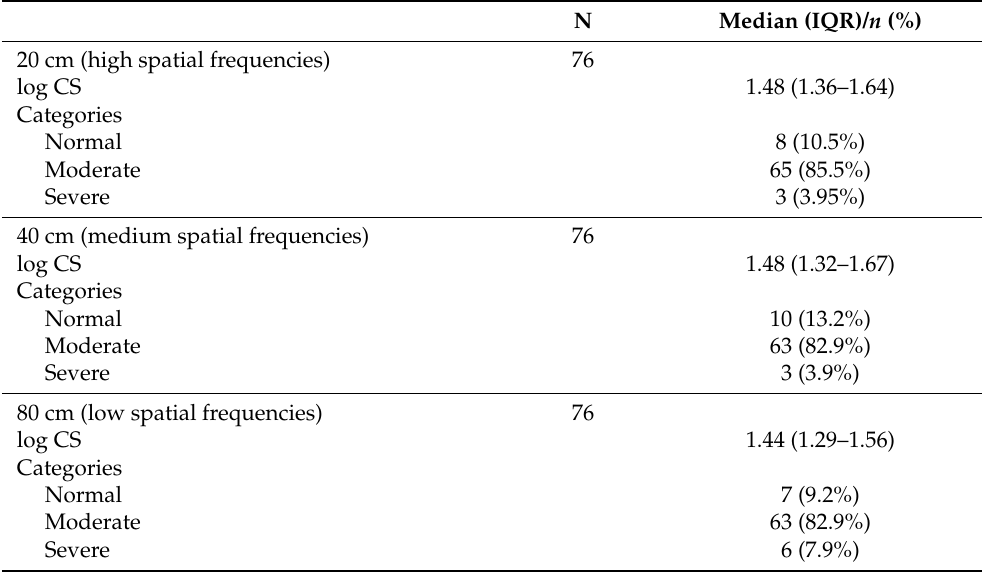
Table 5. Distribution of Mars contrast sensitivity at various testing